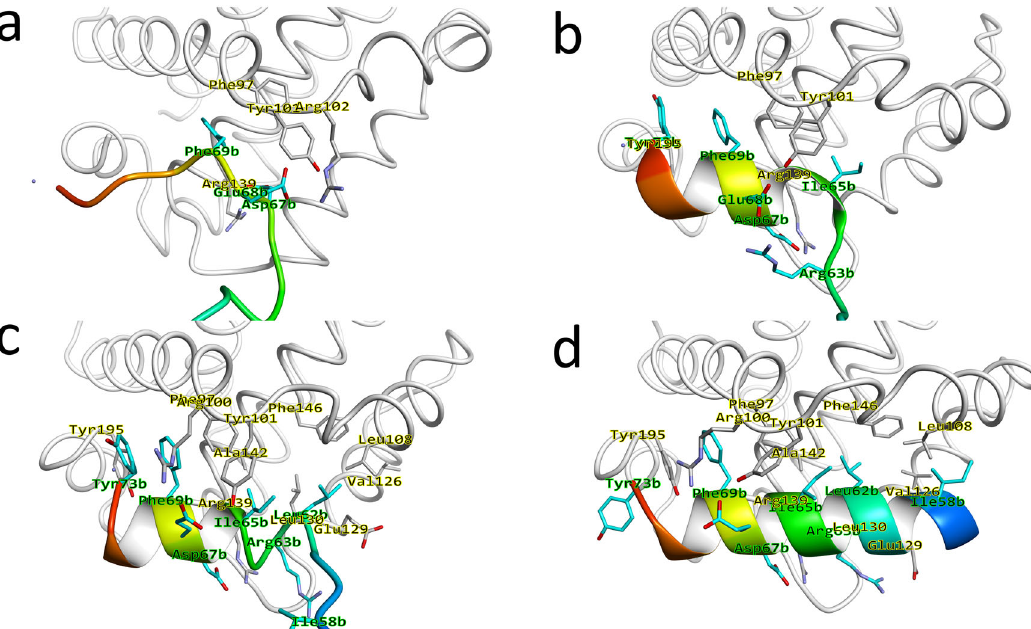
Fig. 3 Milestone structures that de fi ne the binding mechanism between Bcl-xL and Bim. a The structure at λ = 10 Å. b The structure at λ = 8 Å. c The structure at λ = 5 Å. d The structure at λ = 0 Å. In the fi gure, Bcl-xL is shown as a white tube model, while Bim is shown as a blue-red gradient colored cartoon model. Furthermore, important residues from Bcl-xL and Bim are shown as white and cyan stick models, respectively, and indicated in the fi gure in yellow and green,